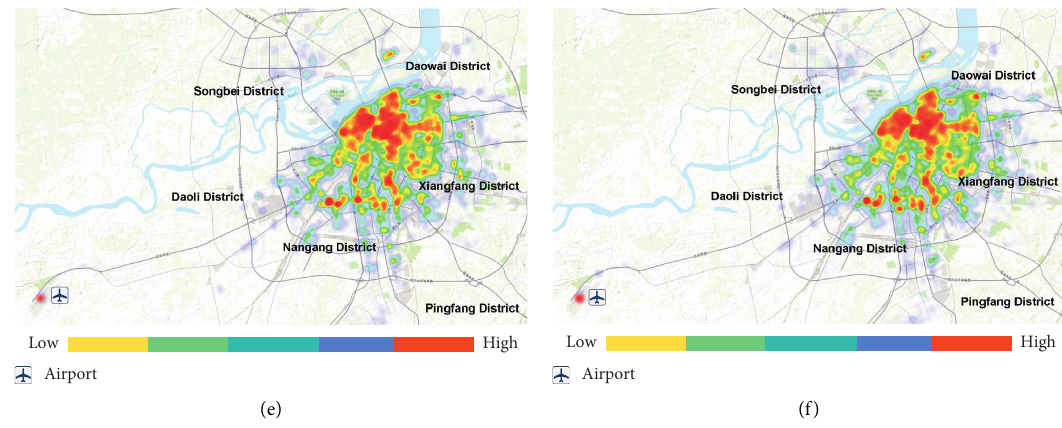
Figure 6: Spatial distribution of PUPs during the 6 days. (a) December 9, (b) December 10, (c) December 11, (d) December 12, (e) December 13, and (f) December 14.